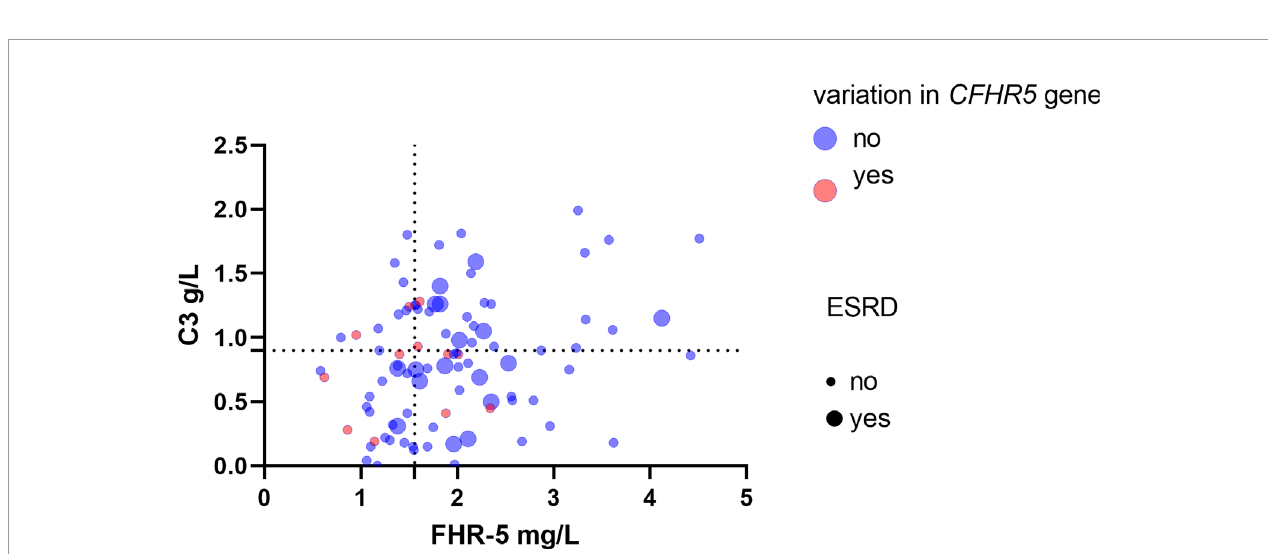
FIGURE 8 | Patients ’ Factor H-related protein 5 (FHR-5) and C3 levels along with the presence of CFHR5 variations and end-stage renal disease (ESRD). Dotted lines indicate the threshold of high and low C3 (0.9 g/L) and FHR-5 (1.565 mg/L) levels. Rates of ESRD during follow-up - C3 <0.9 g/L, FHR-5 <1.56 mg/L: 0.032/ event/patient/year, median (min – max) follow-up: 1.6 (0.11 – 6) - C3 <0.9 g/L, FHR-5 >1.56 mg/L: 0.11/event/patient/year, median (min – max) follow-up: 1.5(0.05 – 6) - C3 >0.9 g/L, FHR-5 <1.56 mg/L: 0/event/patient/year; median (min – max) follow-up: 1.57 (0.21 – 6) - C3 >0.9 g/L, FHR-5 >1.56 mg/L: 0.099 event/patient/year; median (min – max) follow-up: 1.5 (0.13 –